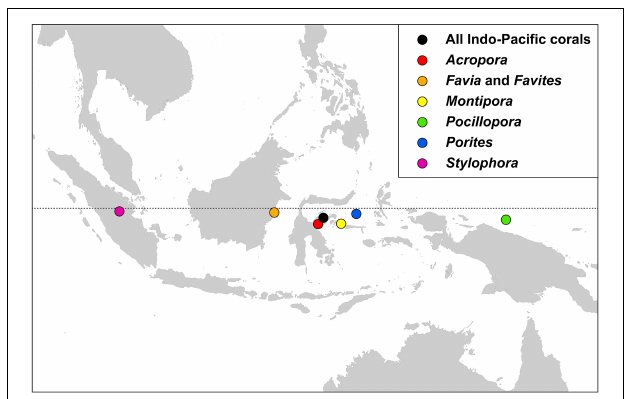
FIGURE 17 | The centroid position of all Indo-Pacific coral records, and those of some major generic groups, see text.